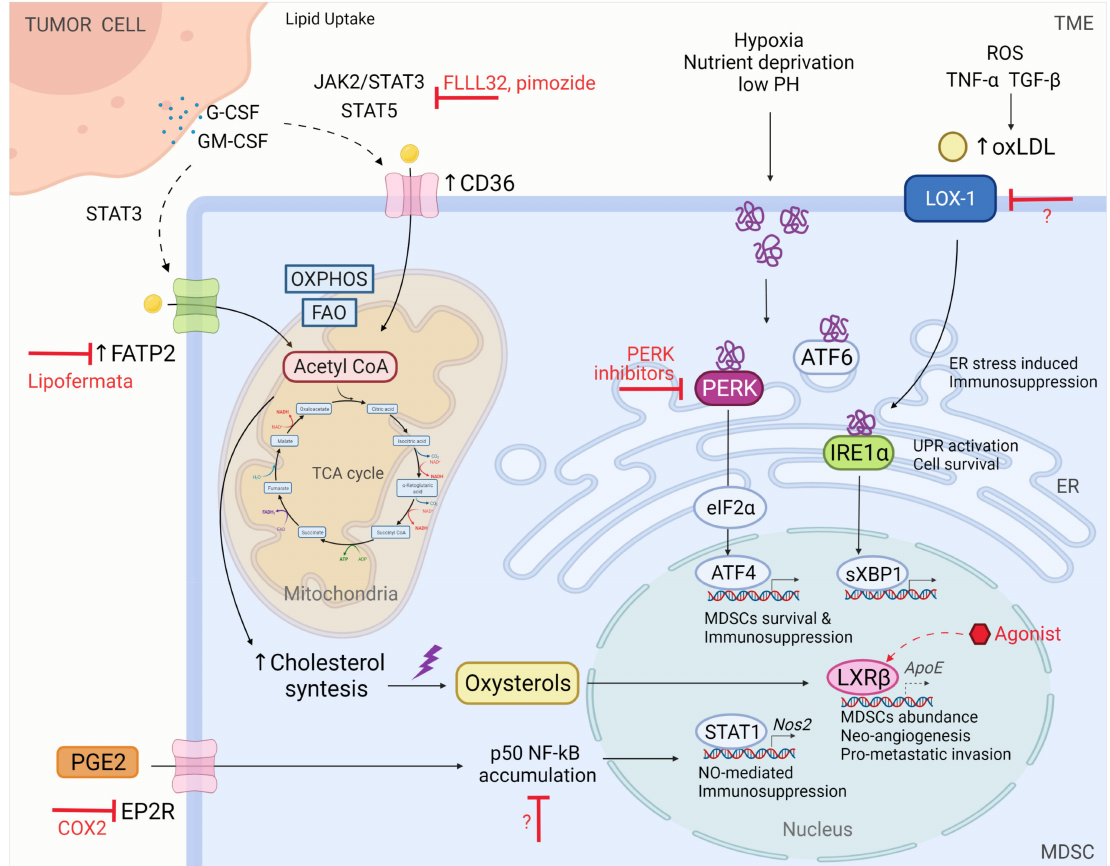
Figure 3. Lipid homeostasis disruption mediates MDSC immunosuppressive function. To sustain their suppressive and tumorigenic functions, MDSCs boost fatty acids oxidation (FAO) and oxidative phosphorylation (OXPHOS). FAO produces Acetyl-CoA, which is essential for ATP and endogenous lipid synthesis. Meanwhile, exogenous fatty acid (FA) uptake occurs thanks to the upregulation of FA transporters such as CD36 and fatty acid transport proteins (FATPs) on the cell surface. Among the broad set of lipids by which MDSCs are replenished, there is arachidonic acid, relevant for prostaglandin E2 (PGE2) production. PGE2 drives nuclear accumulation of p50 protein of NF- κ B, necessary for NO production and NO-mediated immunosuppression. On the other side, the hostile nature of the tumor-microenvironment (TME) induces calcium and lipid homeostasis disruption leading to ER stress and, as a consequence, unfolded protein response (UPR) activation. Oxidative stress conditions also mean lipid oxidation: while oxidized low-density lipoproteins (ox-LDLs) from the TME mediate ER stress-induced immunosuppression involving LDL receptor-1 (LOX-1) receptor, oxysterols through the liver-X nuclear receptor (LXR)/ apoliprotein E (ApoE) axis mediate MDSCs survival and abundance, regulating cholesterol and lipid metabolism. FA, fatty acids; FATP2, fatty acid transport protein 2; ROS, reactive oxygen species; TNF- α , tumour necrosis factor α ; TGF- β , transforming growth factor β ; oxLDL, oxidized low-density lipoprotein (LDL); Nos2, nitric oxide synthase 2; LXR β , liver-X β nuclear receptor; PERK, RNA (PXR)-like ER kinase; IRE1 α , inositol-requiring enzyme 1; eIF2 α , eukaryotic initiation factor 2 α ; sXBP1, spliced X-box binding protein-1; EP2R, PGE2 receptor; COX2, cyclooxygenase